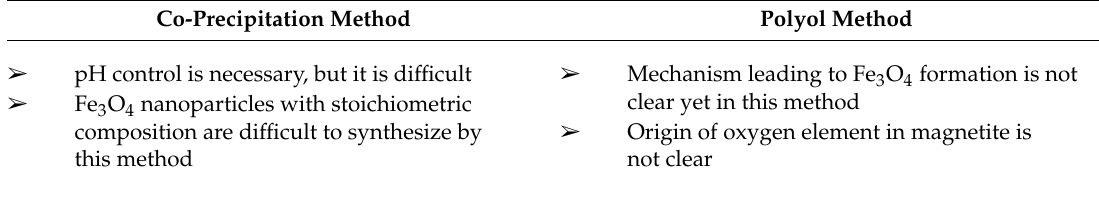
Table 2. Limitations of co-precipitation and the polyol